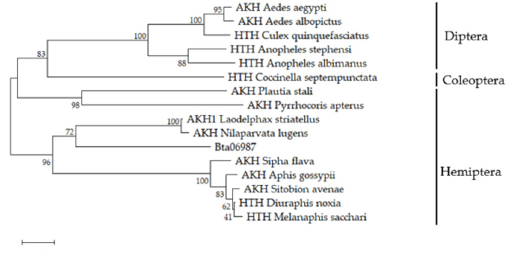
Figure 1. A phylogenetic tree of AKHs sequences. The tree was constructed by Clustal X2 and MEGA 7 with 1000 bootstrap replicates. The bar size indicates the number of amino acid substitutions per site. The GenBank accession numbers of insects AKHs are as follows: Ae. aegypti (CAY77165.1); Ae. Albopictus (JAV47133.1); Cx. quinquefasciatus (XP_001842492.1); An. Stephensi